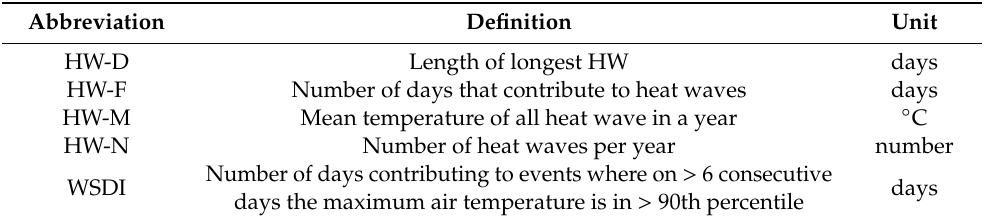
Table 2. Definition of extreme temperature indices according to